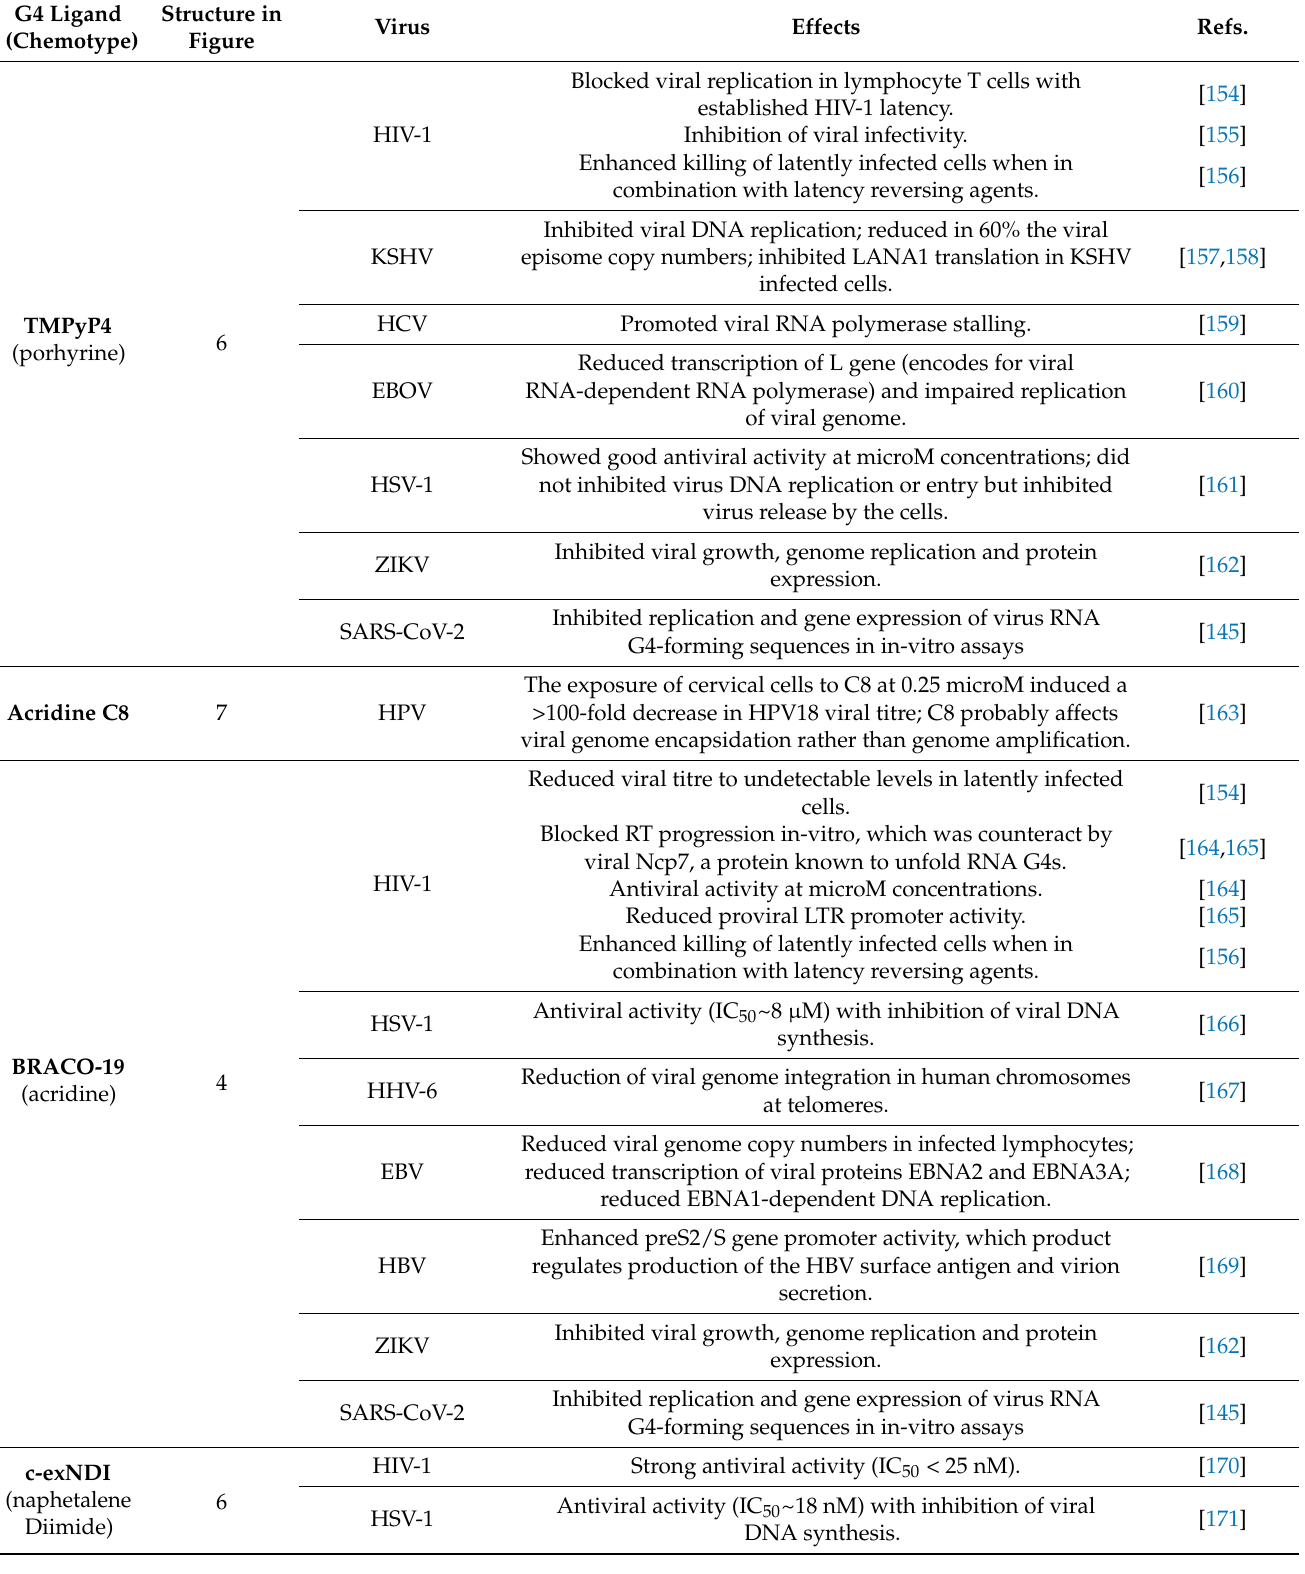
Table 3. Antiviral activity of selected G4 ligands.